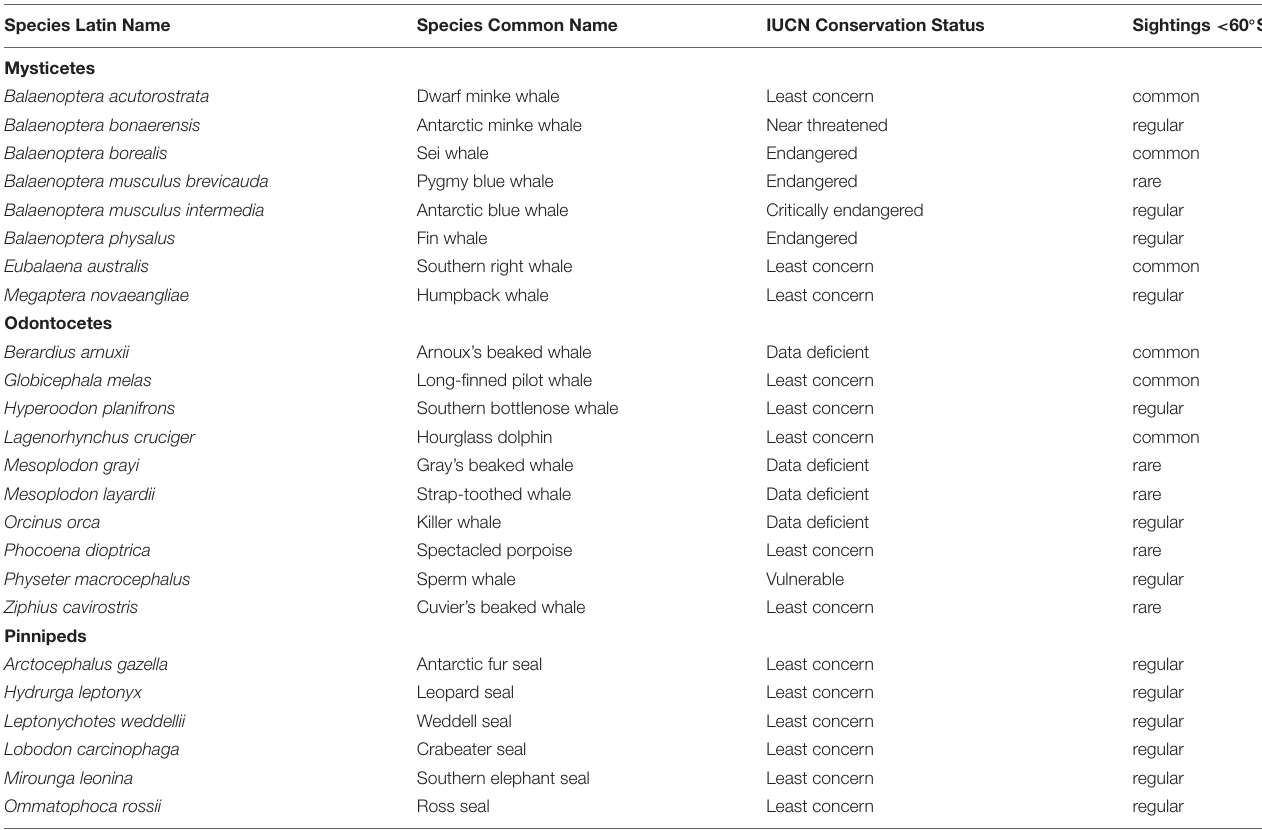
TABLE 1 | Marine mammal species in the Antarctic, based on Ropert-Coudert et al.